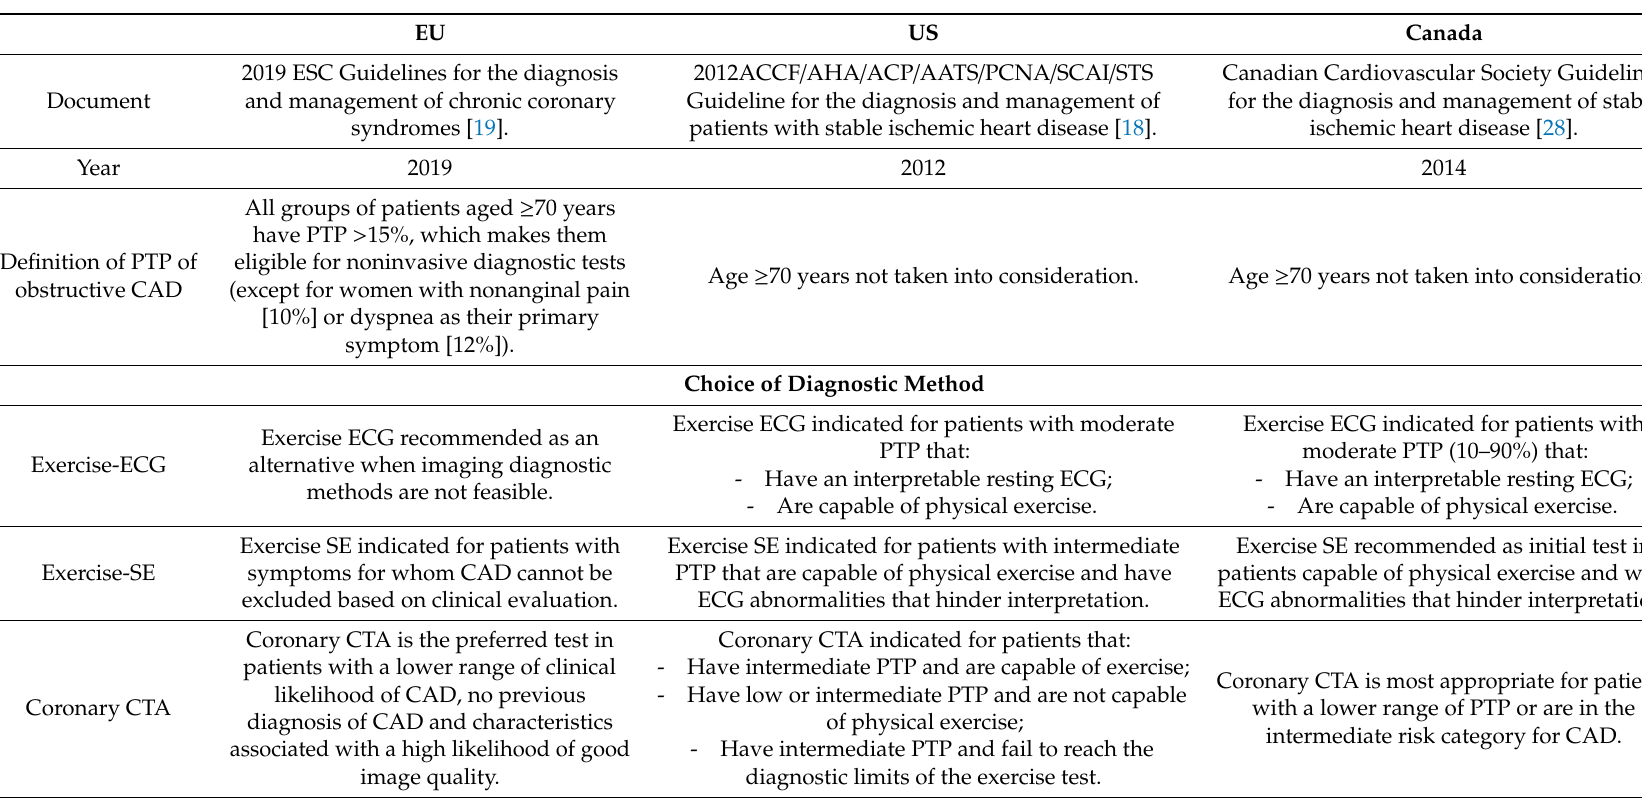
Table 1. Comparative summary of diagnostic method choices of European, United States (US) and Canadian